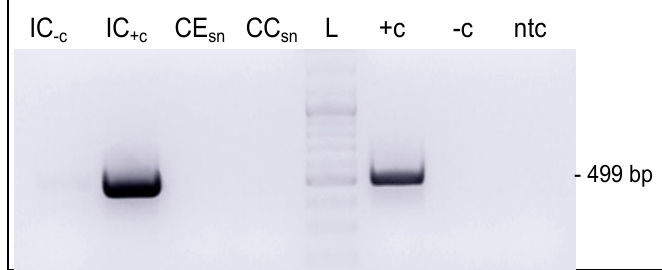
Figure 5. E5 IC/PCR fails to reveal virions in infected cells and culture medium. E5 IC/PCR using 5B6 as capture antibody. IC − c : 100 ng of BPV1 virion DNA in PBS as IC/PCR negative control; IC +c: 2 × 10 4 BPV1 virions in PBS as IC/PCR positive control; CE sn : cell extract supernatant from ArcAi-1